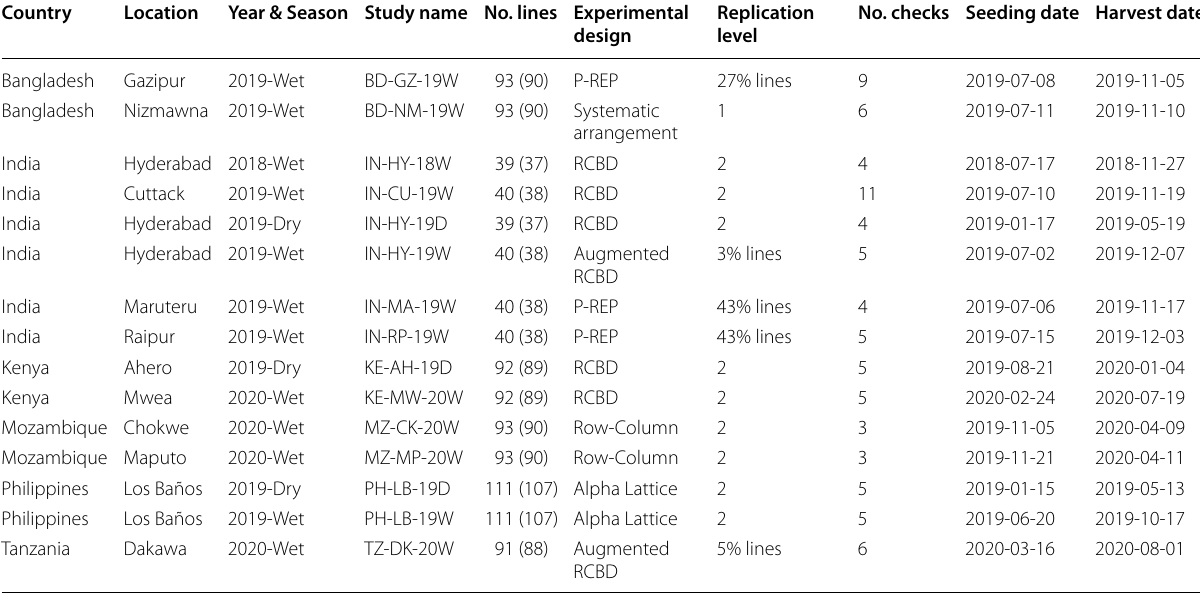
At the No. lines column, the numbers contained within the brackets show the numbers of lines having SNP data from the 1K-RiCA